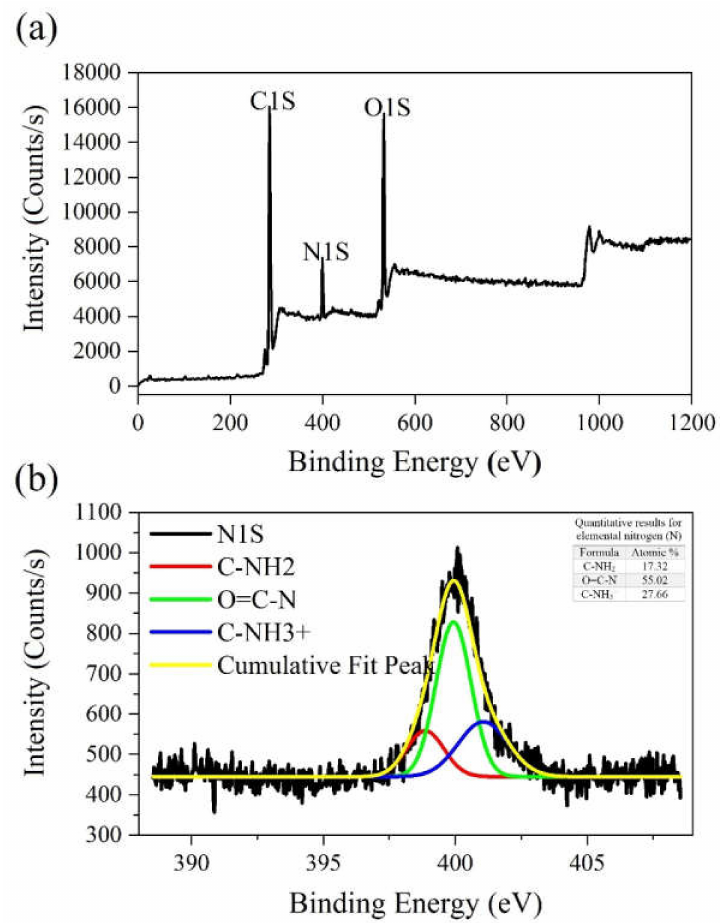
Figure 5. The results of X-ray photoelectron spectroscopy (XPS) spectra analysis: ( a ) Collagen / chitosan-grafted PCL membranes; ( b ) detailed and quantitative analysis of elemental nitrogen